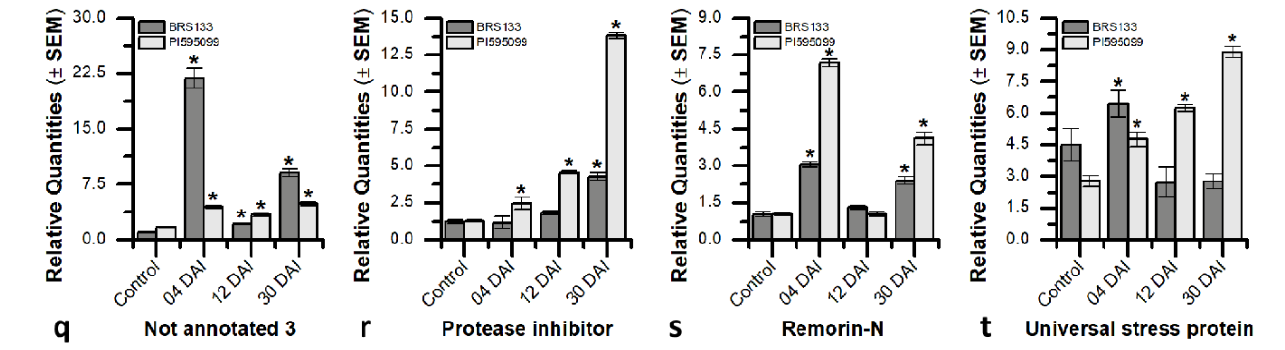
Figure 6. Validation of differentially expressed genes profile. The graphs show the RT–qPCR relative expression (2 ∆∆ Ct ) of 20 candidate genes selected after comparison of transcriptome and proteome data from two soybean genotypes (BRS 133 and PI 595099) inoculated (4, 12, and 30 days after inoculation—DAI) and not inoculated (0 DAI) with the nematode M. incognita . ( a ) acid phosphatase-related ( GmAPHO ; Glyma.08G200100.1); ( b ) alcohol dehydrogenase related ( GmALCD ; Glyma.04G240800.1); ( c ) annexin D1-related ( GmAND1 ; Glyma.13G088700.1); ( d ) auxin associ-